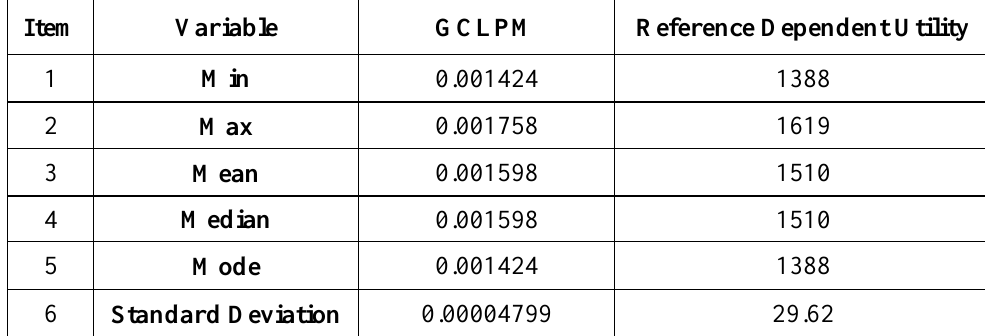
Table 8. Result Specification of Scenario 2 in Third